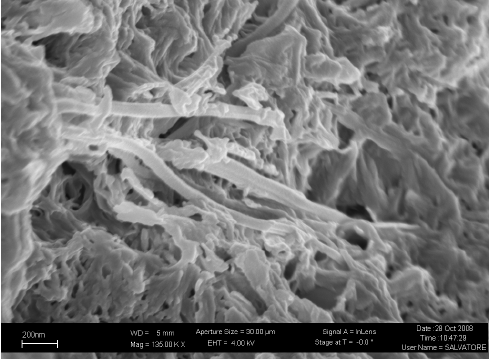
Figure 4: SEM micrograph of 0.5 wt% MWCNT cement composite